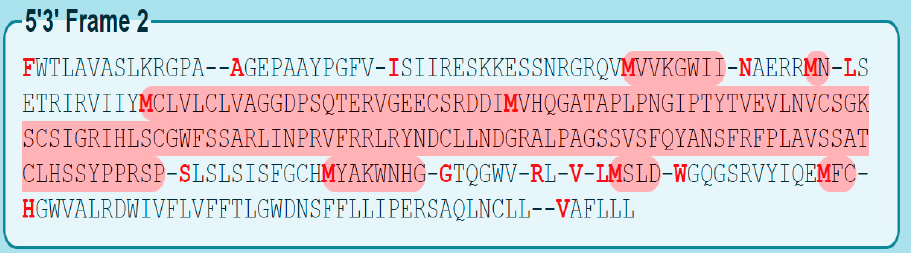
Figure 7. Translated protein sequence of TPD 1-like gene containing 132 amino acids (highlighted).